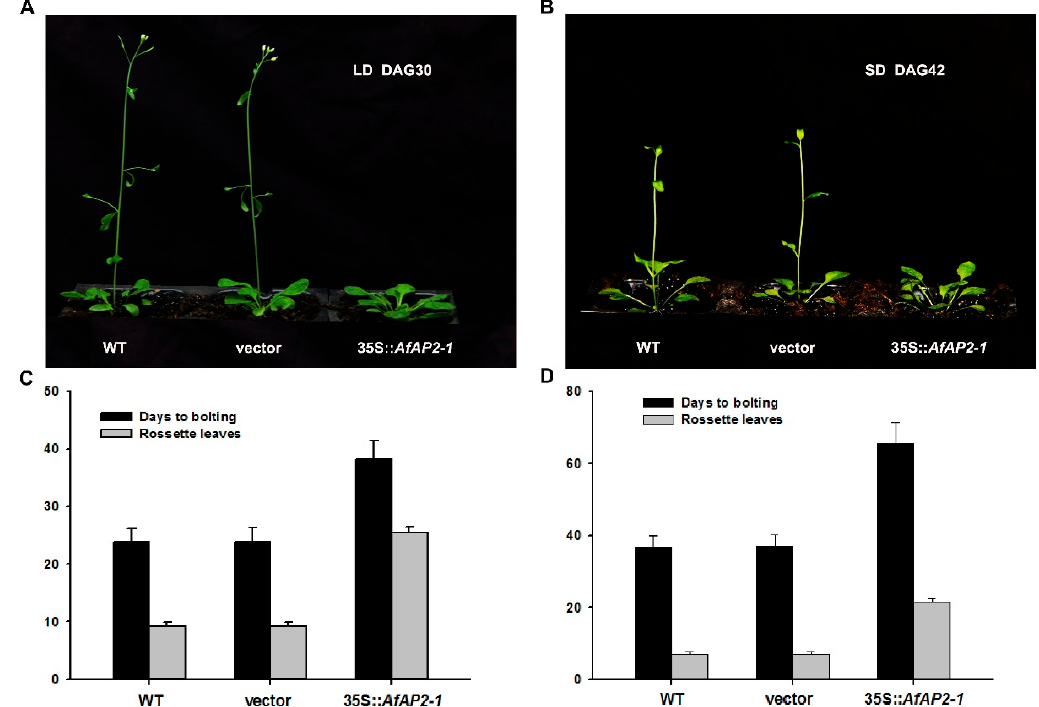
Figure 6. Heterologous expression of AfAP2-1 in Arabidopsis . ( A ) Phenotypes of transgenic plants grown under LD conditions at 30 days after germination (DAG); ( B ) Phenotypes of transgenic plants grown under SD conditions at 42 DAG; ( C ) Days and rosette leaves to bolting of WT and transgenic plants grown under LD conditions; ( D ) Days and rosette leaves to bolting of WT and transgenic plants grown under SD conditions. Values are means ± standard deviation of the results from 26 individual plants of WT, 21 individual plants of WT transformed with the empty vector and 16 individual plants of AfAP2-1 -OX lines.